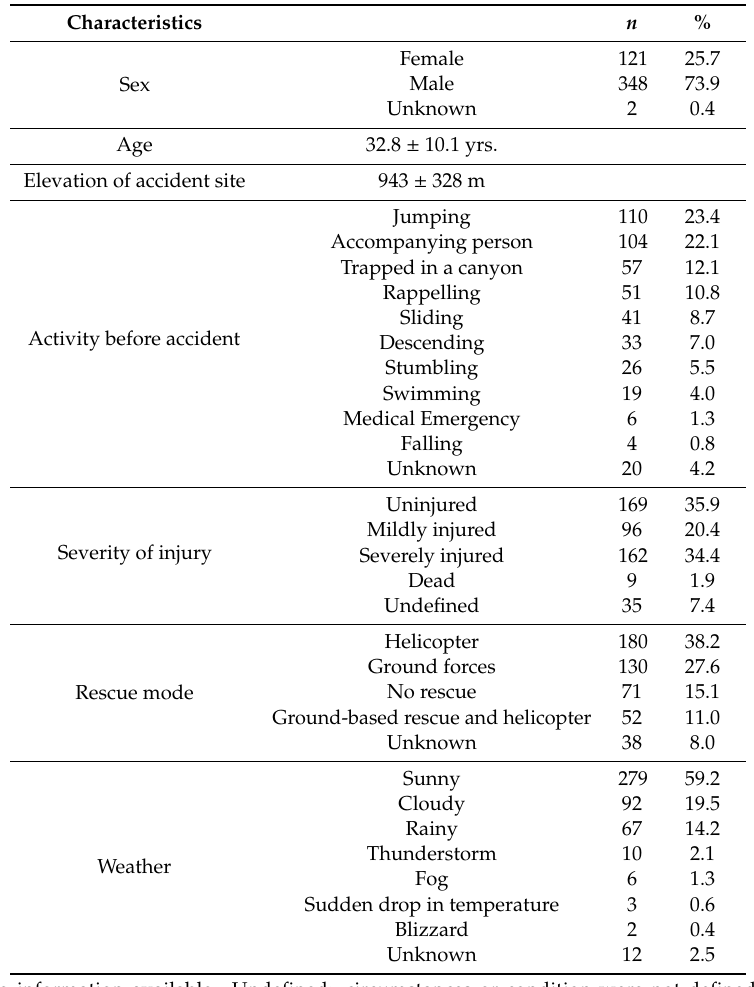
Table 1. Characteristics of canyoning emergencies in Austria from November 1, 2005 to October 31, 2018. Activities, mode of rescue and weather are listed according to their